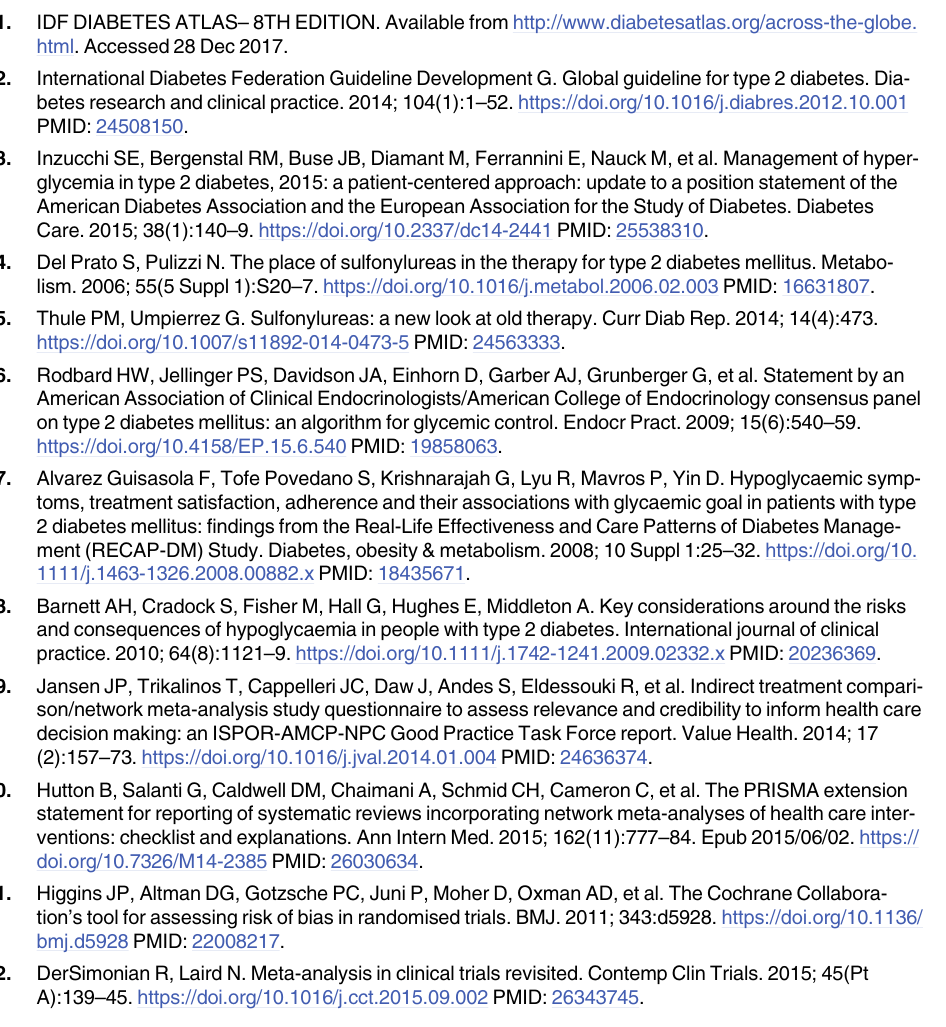
S3 Fig. Comparison-adjusted funnel plot for efficacy and safety